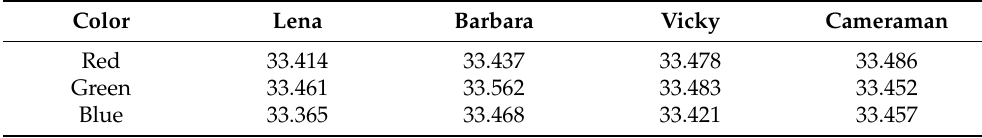
Table 6. UACI of the test images after